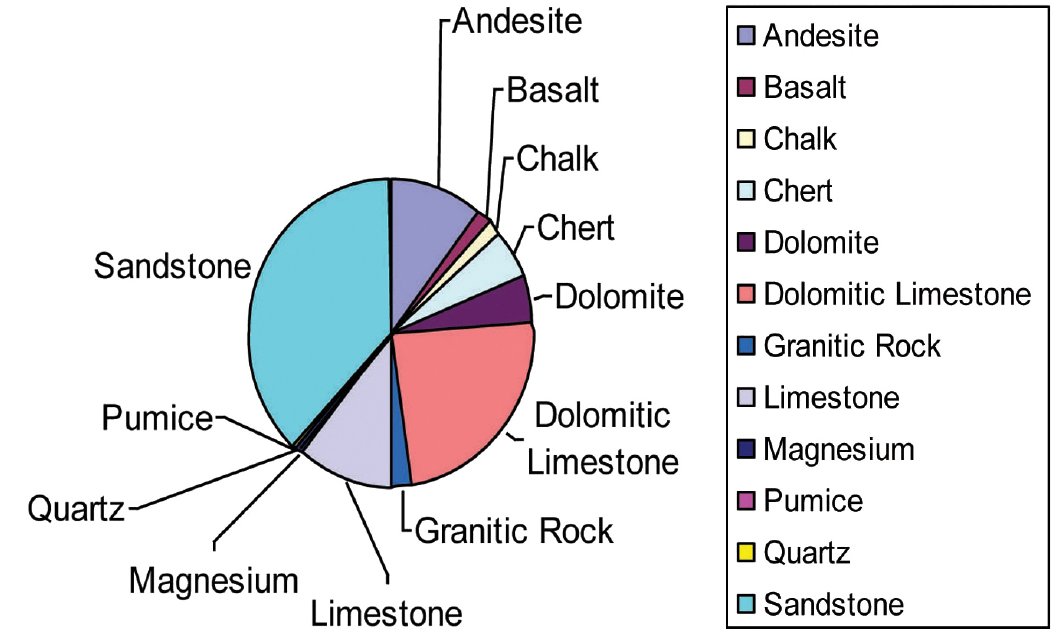
Figure 10. Relative lithic material distribution of assemblage